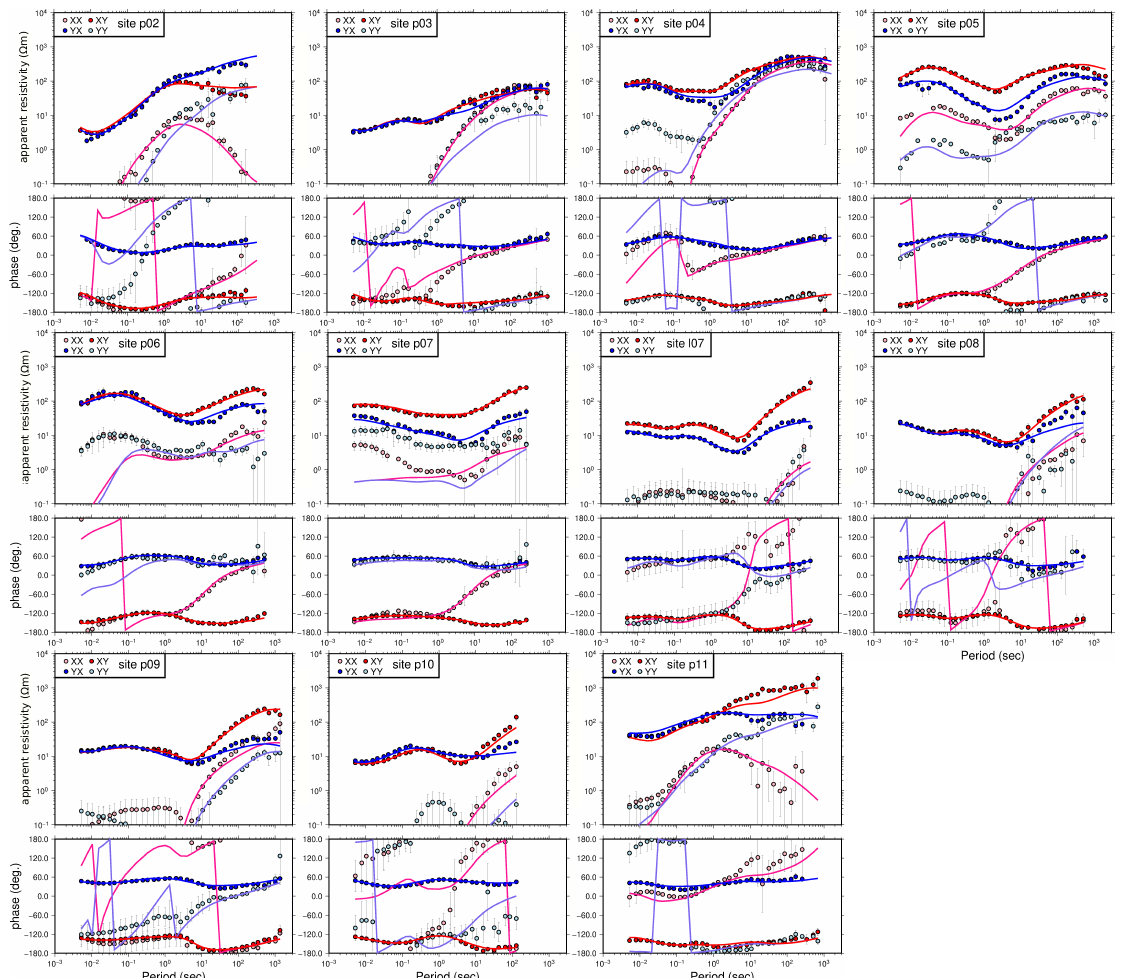
Figure A3. MT impedance tensor for all northern profile sites (see Figure 1B for location). The four complex tensor components are Z xx (pink), Z yy (cyan), Z xy (red) and Z yx (blue) shown as apparent resistivity and phase (dots). The error bars are one standard deviation. Full lines correspond to the response of the best 3-D model. See text for